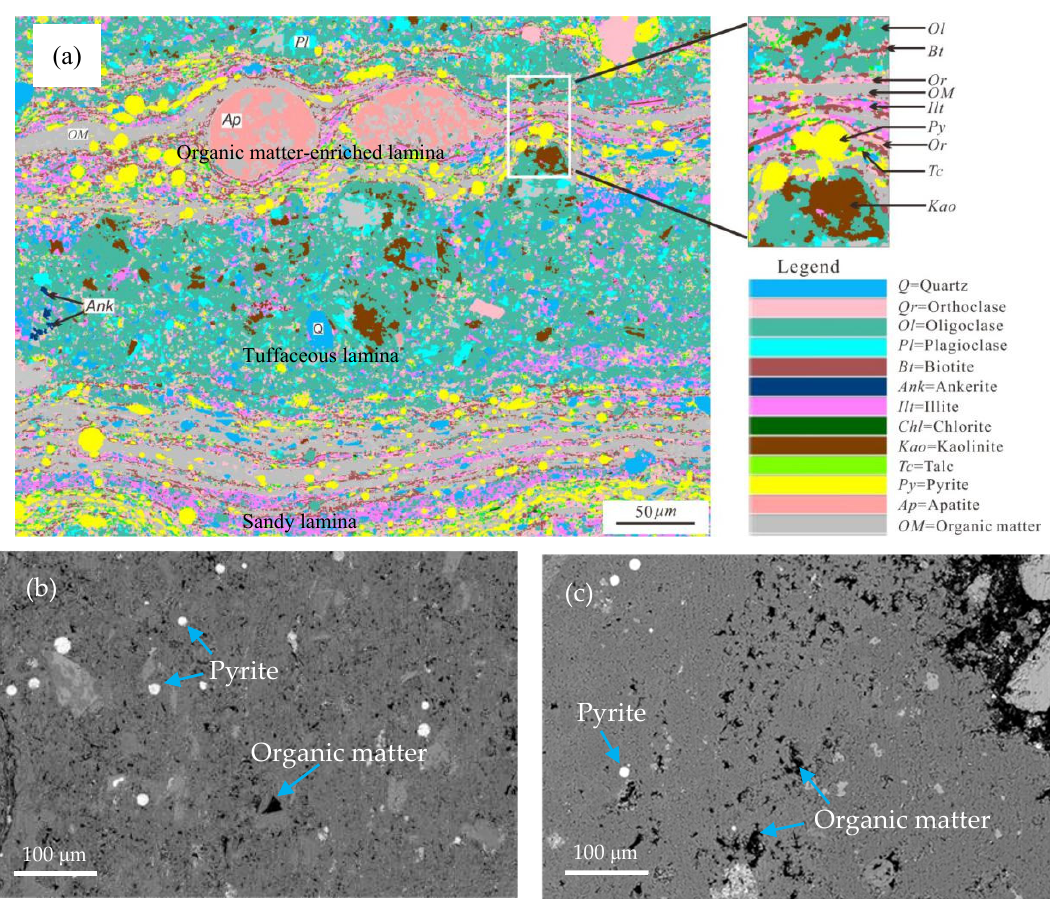
Figure 2. Mineral distribution of the Chang 7-2 shale sample. ( a ) BSE image [26]; ( b ) SEM image showing pyrite and organic matter uniformly distributed in the sandy layer; ( c ) SEM image showing a small quantity of pyrite and a good deal of organic matter distributed in the tuffaceous layer.